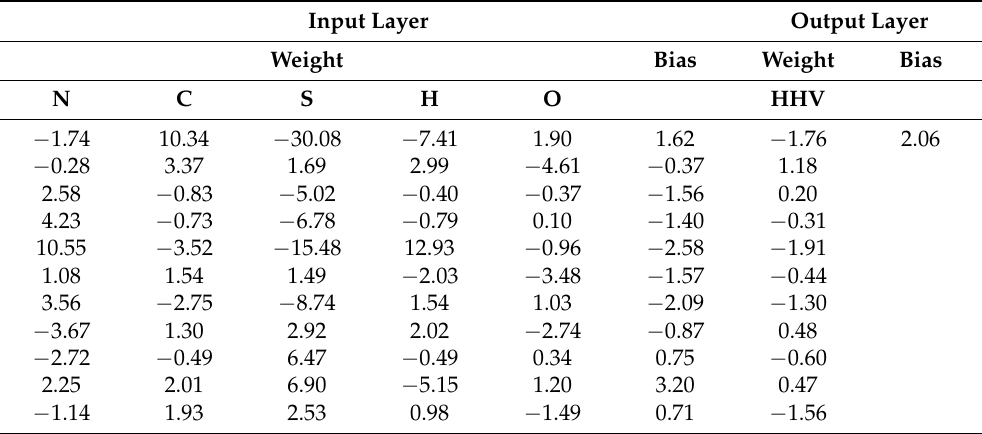
Table 4. Weights and biases of input and output